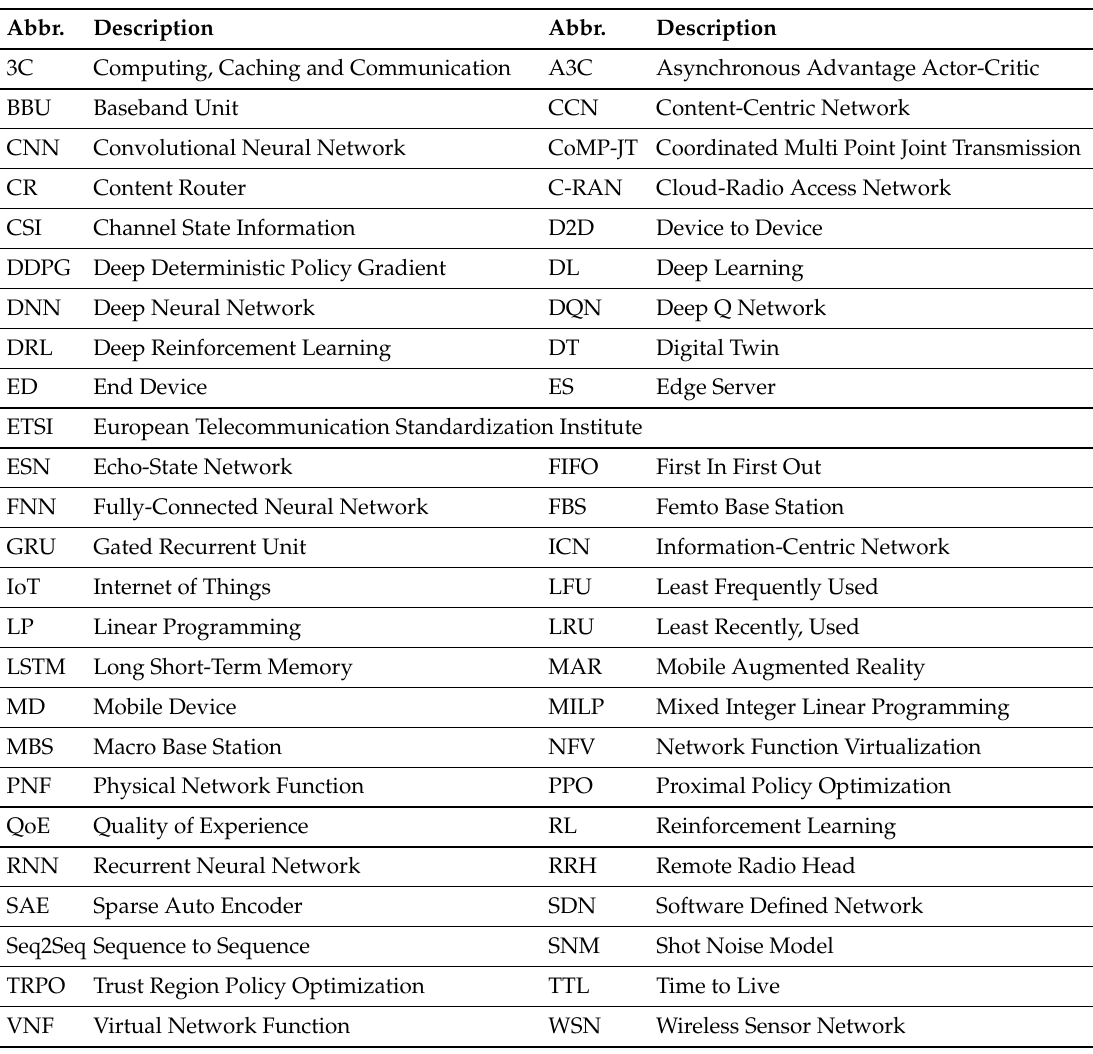
Table 1. List of